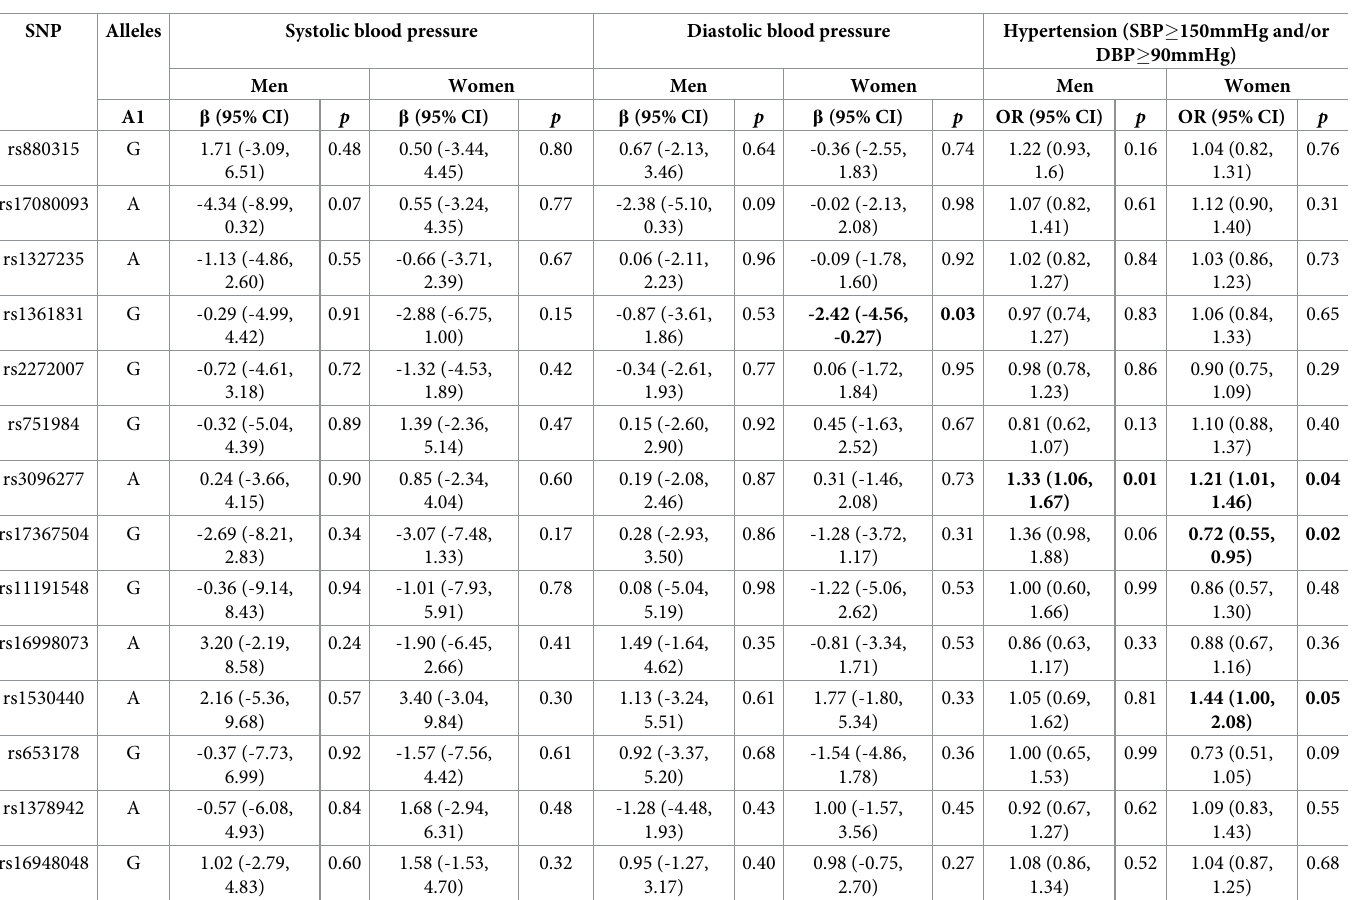
CI = -6.46, -1.38 and β = -1.87, 95%CI = -3.50, -0.25 respectively, both p < 0.05) and weakly associated with increase in SBP and DBP among mid-aged men (though not statistically signif- icant β = 2.90, 95%CI = -0.24, 6.03; p = 0.07 and β = 1.91, 95%CI = -0.04, 3.87, p = 0.06). Among individuals age 30–60 years rs880315 was associated with increased risk of hyperten- sion (OR = 1.20, 95% CI = 1.04, 1.38, p = 0.01) ( Table 4B and 4C ). rs16948048 found to be sig- nificantly differ among hypertensive and non-hypertensive group of younger individuals (OR = 1.31, 95% CI = 0.04, 1.77, p = 0.011). Younger individuals, particularly women with A allele of SNP rs1530440 were likely to have higher both SBP and DBP measurements (younger individuals β = 4.1, and β = 2.5, for SBP and DBP, respectively and younger women β = 4.5, and β = 2.9, for SBP and DBP, respectively, all p < 0.05) (Table 4B). However, the same